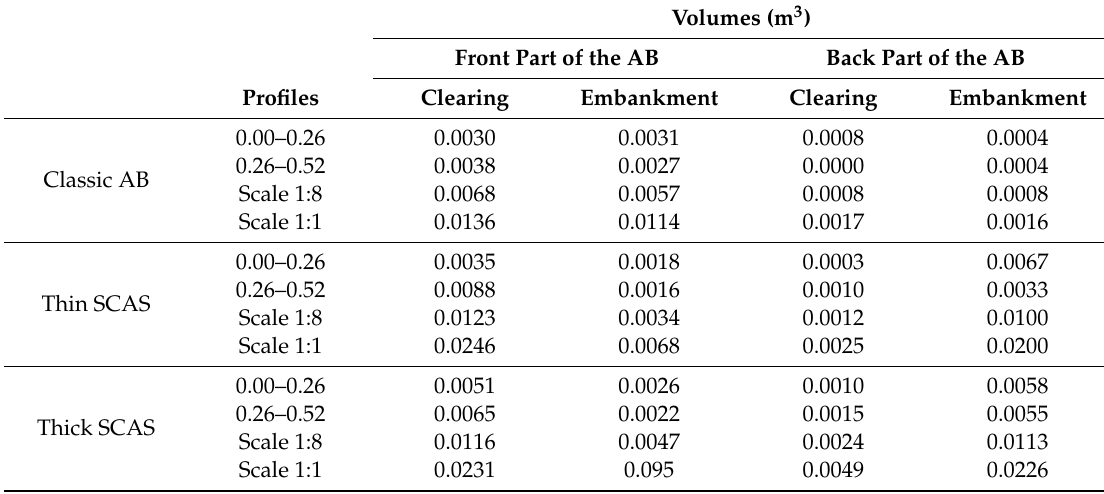
Table 3. Cubication of the sand displaced by the e ff ect of the airflow in the scaled wind tunnel for each of the ABs tested both on a full scale (1:1) and on a scale of